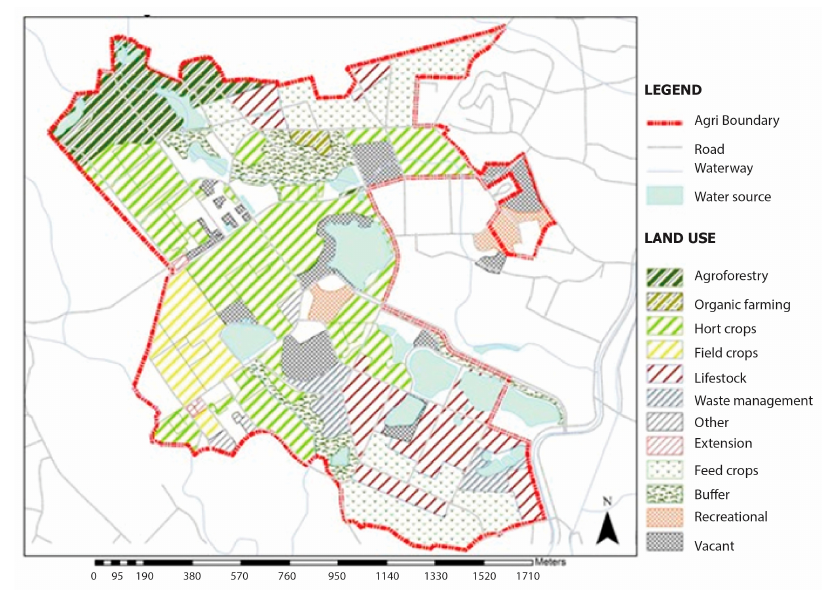
Figure 3. Land use of the site based on site observation and interview between August 2018 and September 2019.